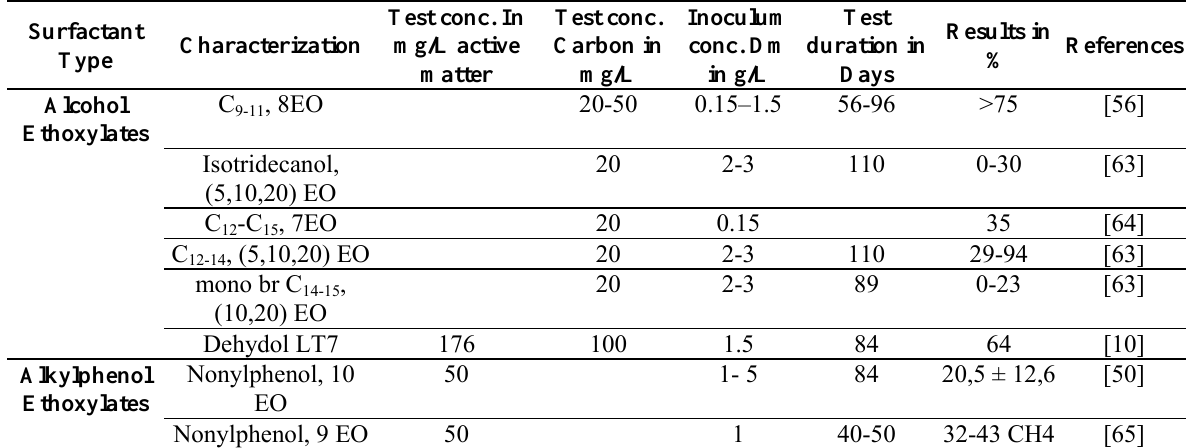
Table 6. Anaerobic biodegradability of nonionics in screening tests (according ECETOC). Surfactant